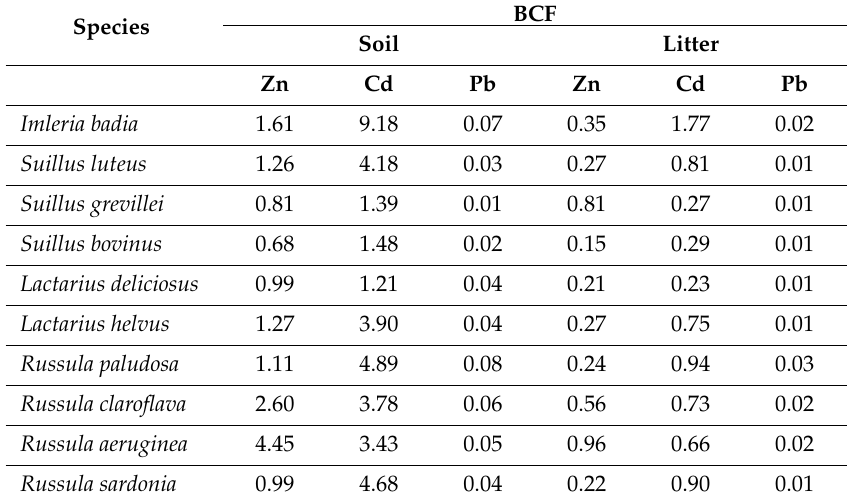
Table 6. Bioconcentration factor (BCF) of heavy metals for individual mushroom